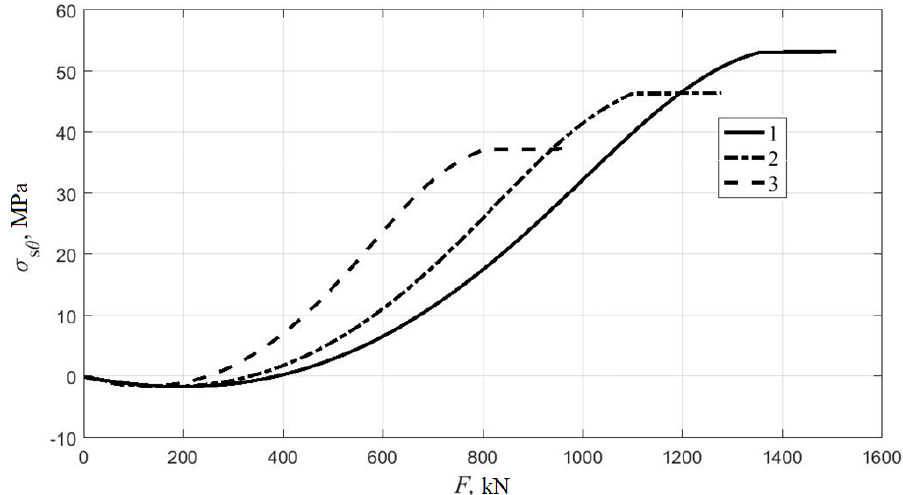
Figure 10. Dependence of stresses σ s θ at y = R on load.